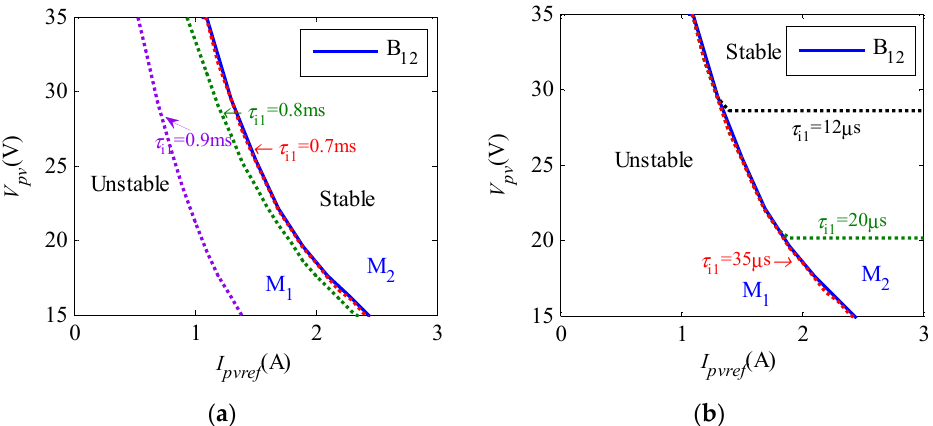
Figure 6. The stability boundaries of output voltage control loop: ( a ) Stability boundaries in M 1 ; ( b ) Stability boundaries in M 2 .